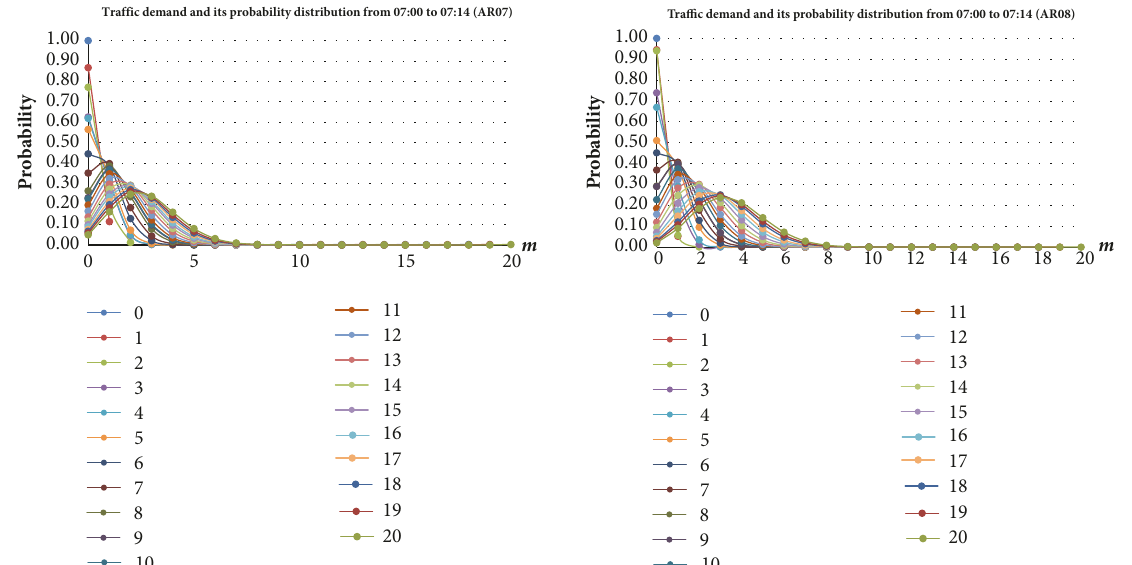
Figure 9: Traffic demand and probability density function of each sector in interval 07:00-07:14.